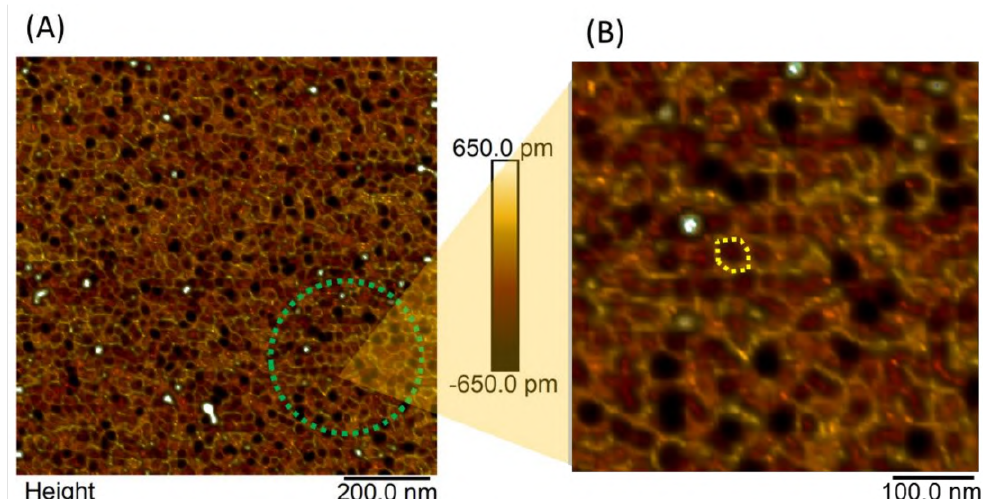
Figure 3. AFM height image of RcAlb -PepIII film on mica. ( A ) A chain of peptides (green line circle) that overlaps over the film of the peptide solution. ( B ) The organization of the peptides in the solution film, the yellow detail shows a hexagonal type of structure like a